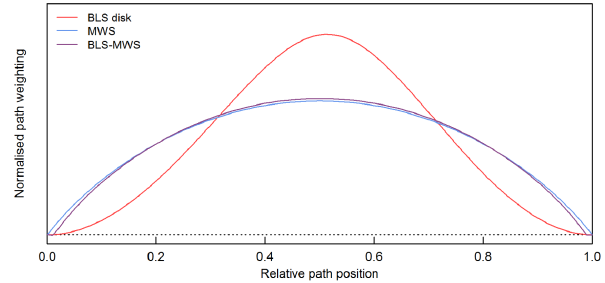
Figure 3. Path-weighting functions for the infrared scintillometer (BLS disk), the MWS and the BLS–MWS combination, normalised so that the total area under each curve equals